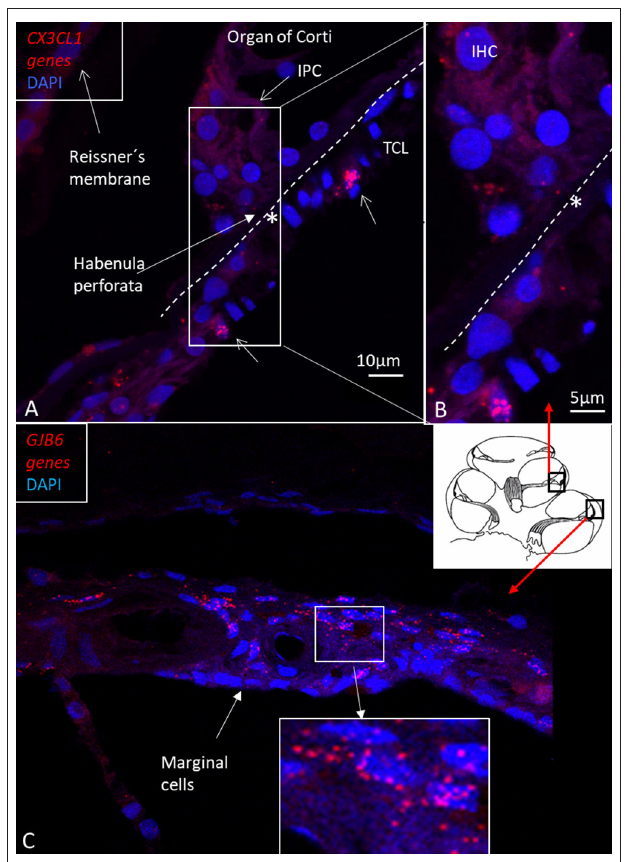
FIGURE 12 | (A) RNA-scope ISH and SR-SIM of CX3CL1 gene transcripts in the region of the IHC and BM (*). Framed area is magnified in (B) . Supporting cells contain a few puncta, mostly in cell nuclei. Some cells in the TCL contain numerous gene puncta (arrows). IPC: inner pillar cell. TCL: tympanic covering layer. IHC: inner hair cell. (C) RNA-scope ISH and SR-SIM of GJB6 gene transcript localization in the lateral wall of the human cochlea. The framed area is magnified in the lower inset. Gene transcripts are restricted to cells located lateral to the marginal cells, which is consistent with Cx30 protein expression.